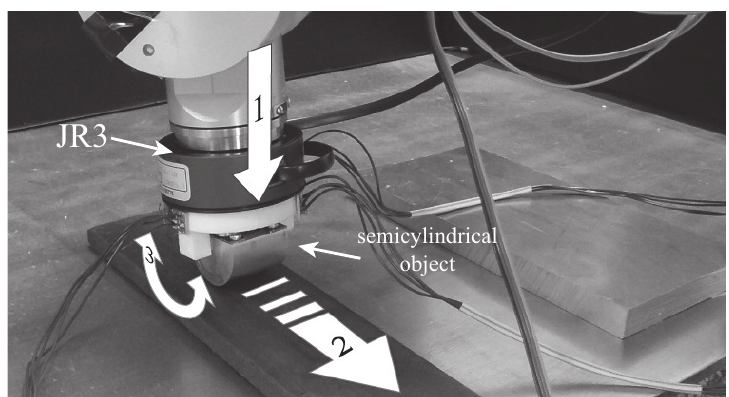
Figure 16. Experimental setup with JR3.